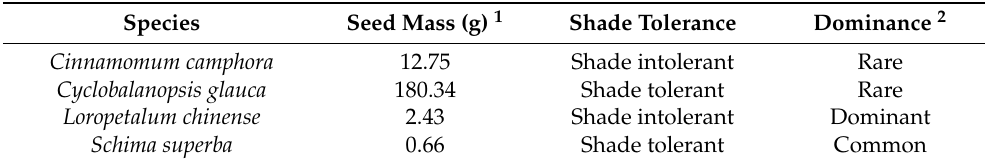
Table 1. The attributes of experimented species. Species Seed Mass (g) 1 Shade Tolerance Dominance